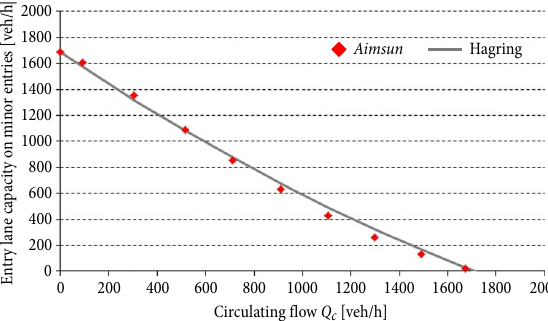
Fig. 1. The sketch of the basic turbo-roundabout (a) and the turbo-roundabout model in Aimsun (b)